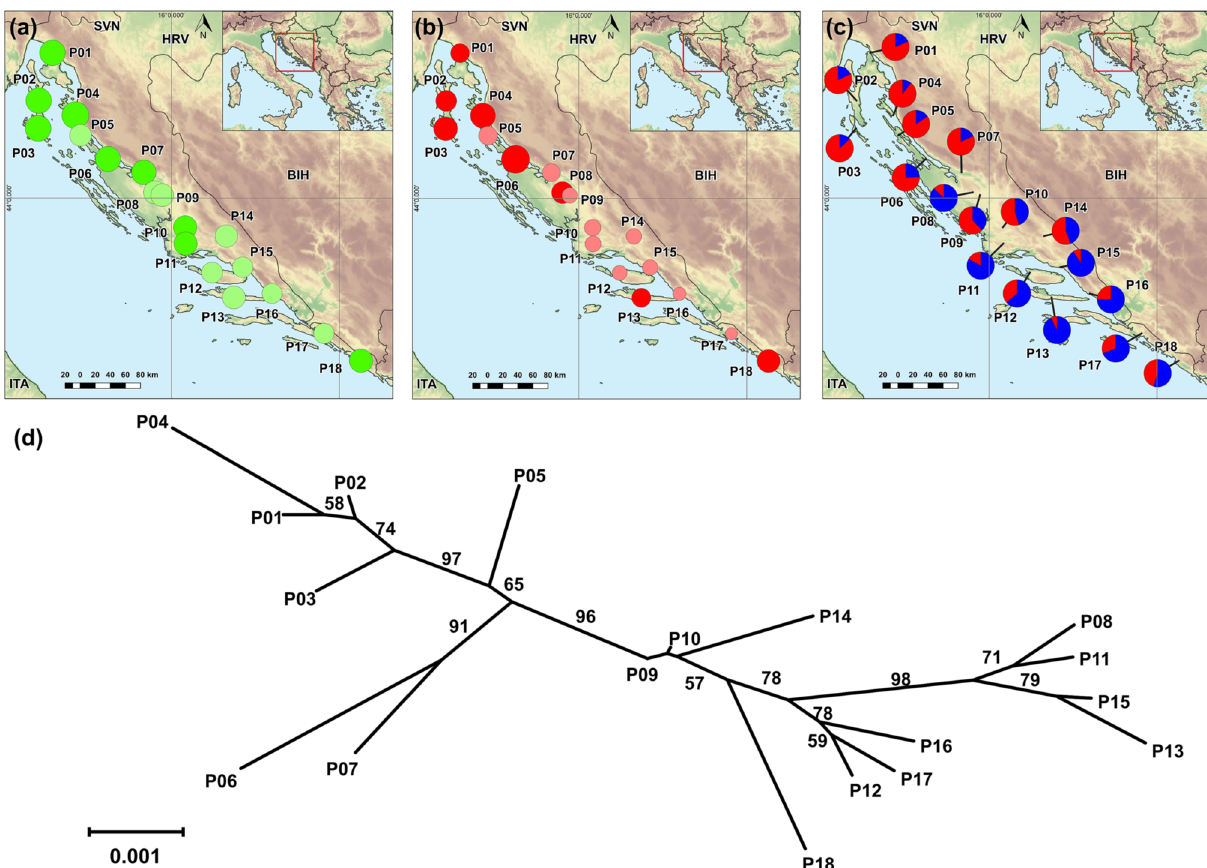
Figure 1. Genetic diversity and relationships among 18 H. italicum populations along eastern Adriatic coast: ( a ) Shannon’s information index, ( b ) Frequency down-weighted marker values, ( c ) Genetic structure derived from Bayesian analysis using STRU CTU RE at K = 2, ( d ) the Fitch-Margoliash tree based on Nei’s genetic distance matrix between populations. Bootstrap values greater than 50% based on 1000 pseudorepeats are marked on the branches. In ( a ) and ( b ), the size of the dots is directly proportional to the depicted values. Maps were generated using QGIS 3.10.7 (https:// qgis.